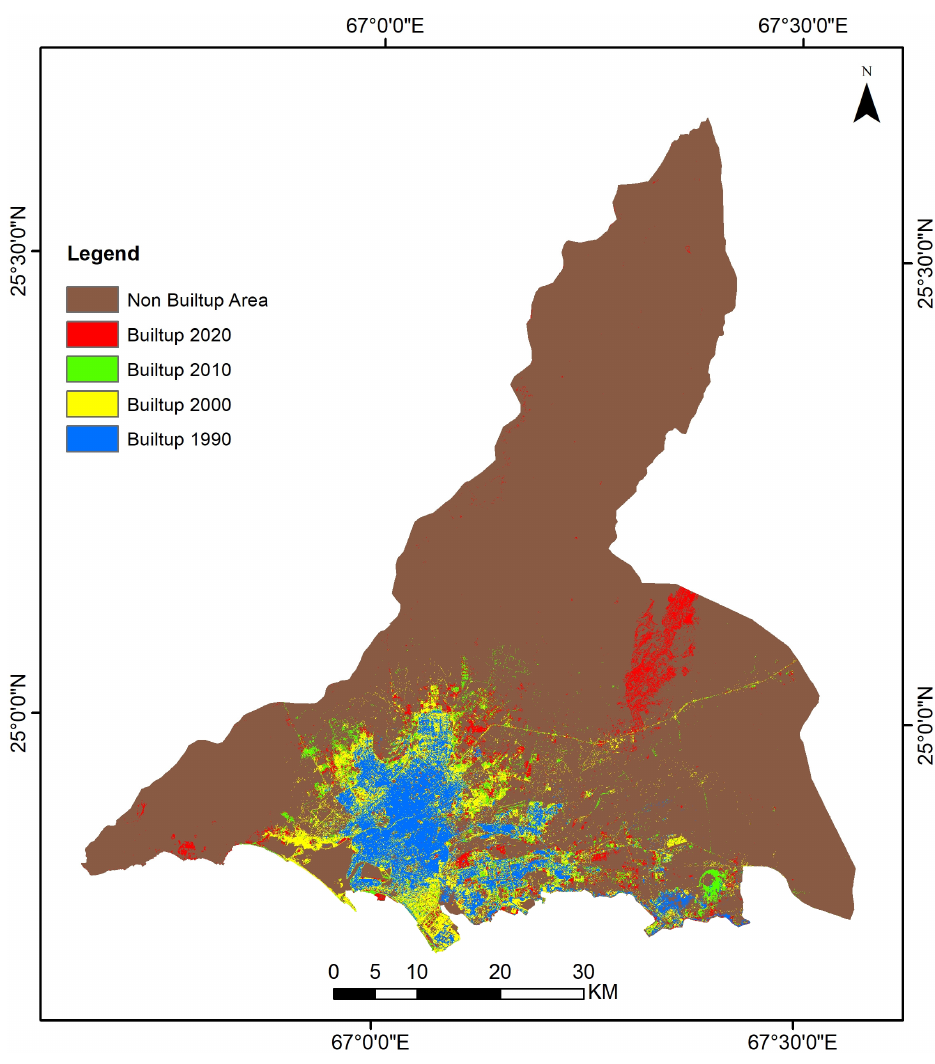
Figure 5. Built-up area expansion in Karachi in 1990, 2000, 2010, and 2020. Figure 6 shows the land transformation in various districts and time periods induced Table 4. Built-up area increases in each district of Karachi (in percentage). by the process of urbanization. The majority of areas converted to urban land at the ex- pense of open bare land, grassland and shrub land, and agricultural land (Table 5). Table 5. Land transformation from other LULC classes to built-up area during the periods of 1990–2000, 2000–2010, and